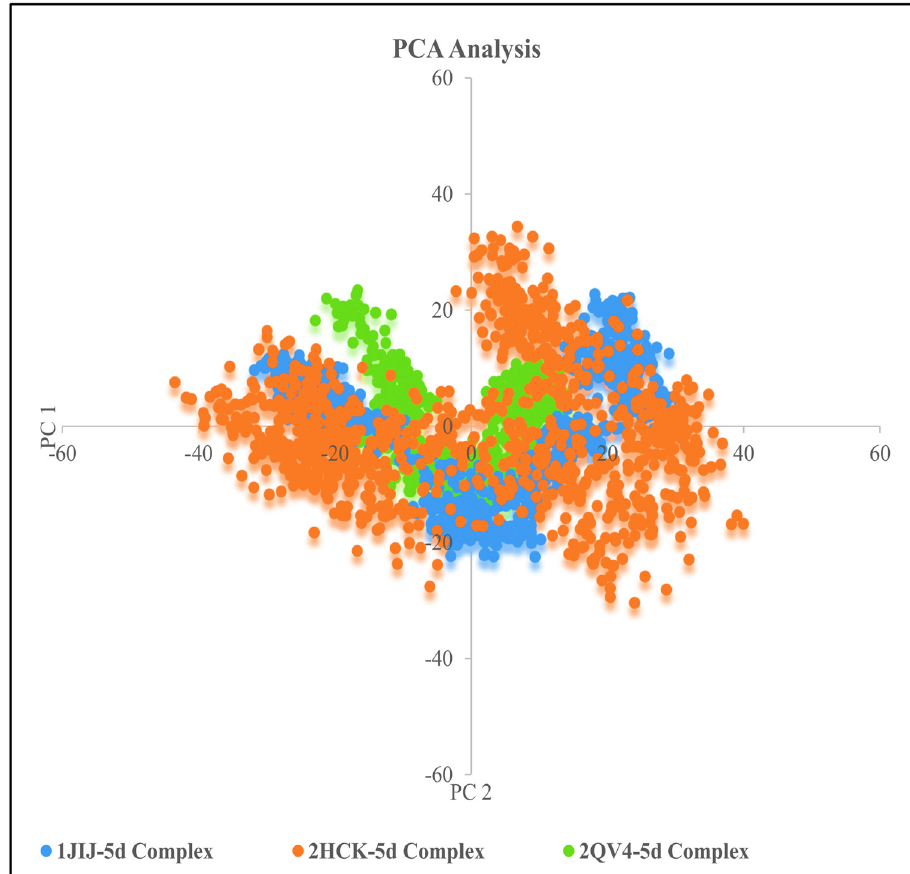
Figure 8. Two-dimensional projection of motion of trajectory of compound 5d bound with proteins over the PC1 and PC2.